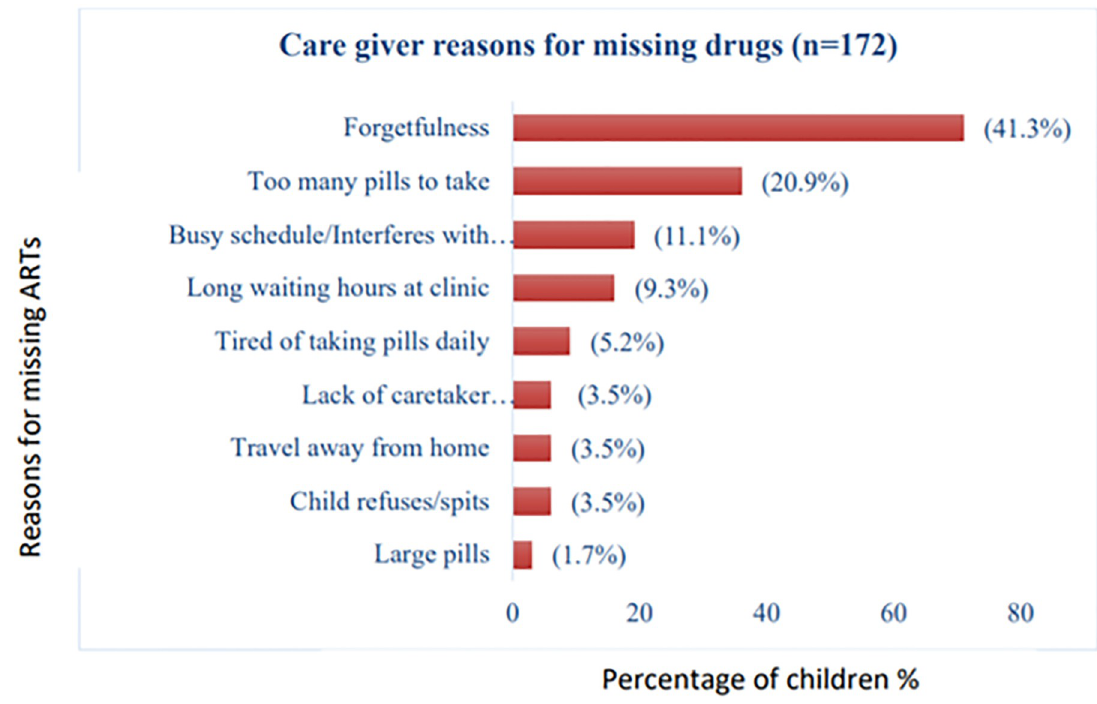
Fig 4. Reasons for missing doses in HIV infected